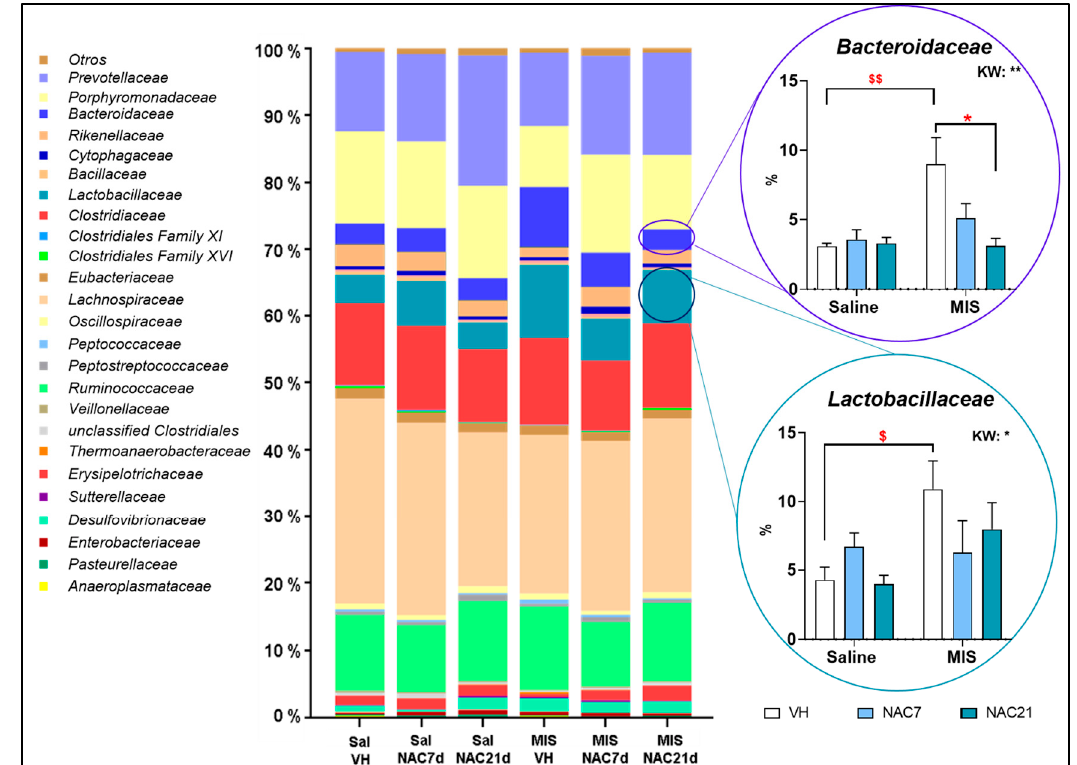
Figure 3. Nested bar plot showing gut microbiota composition at the family level . Differences in average intestinal microbiota composition at the family level. The nested bar graph shows the mean percentage composition of the most representative families for each group. A higher proportion of Bacteroidaceae and Lactobacillaceae families was found in MIS-VH animals compared to the control group (Sal-VH), which was prevented by NAC treatment. Kruskal–Wallis (KW) analysis followed by Dunn’s multiple comparison test (* p < 0.05, ** p < 0.01) and Mann–Whitney test ( $ p < 0.05, $$ p < 0.01) are shown.